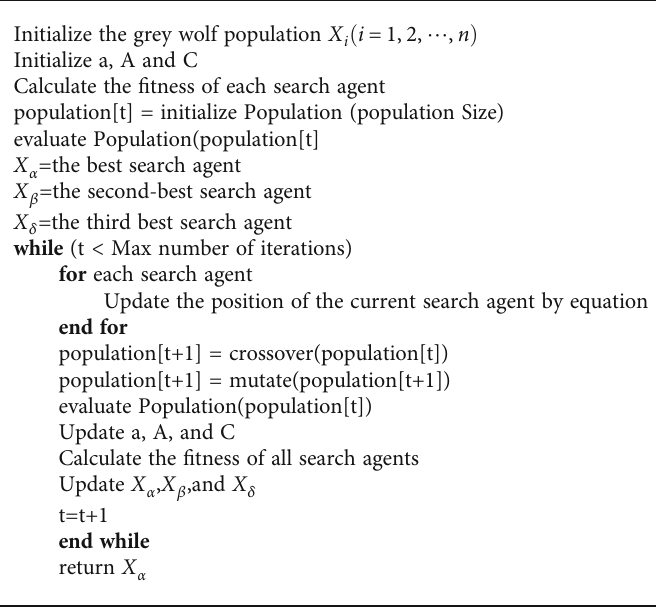
Pseudocode 2: Pseudocode of the cross-mutation grey wolf